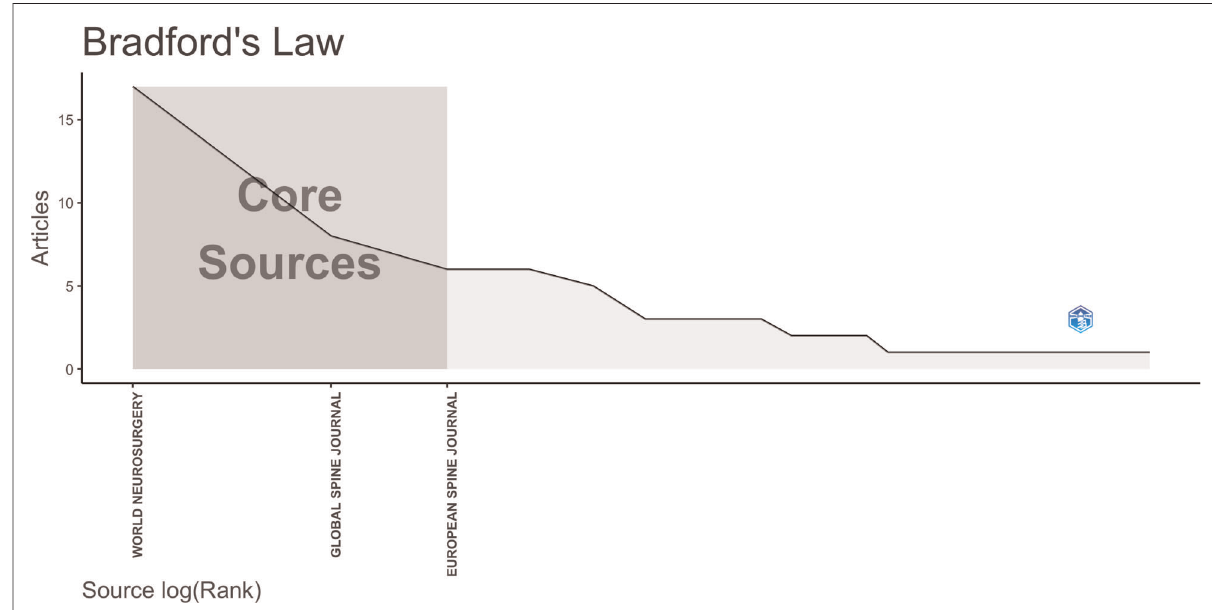
FIGURE 4 Bradford ’ s Low map. The journal located in Core Sources is this journal published a larger number of articles on spine surgery and COVID-19, indicating it as a core journal in this fi eld (generated by